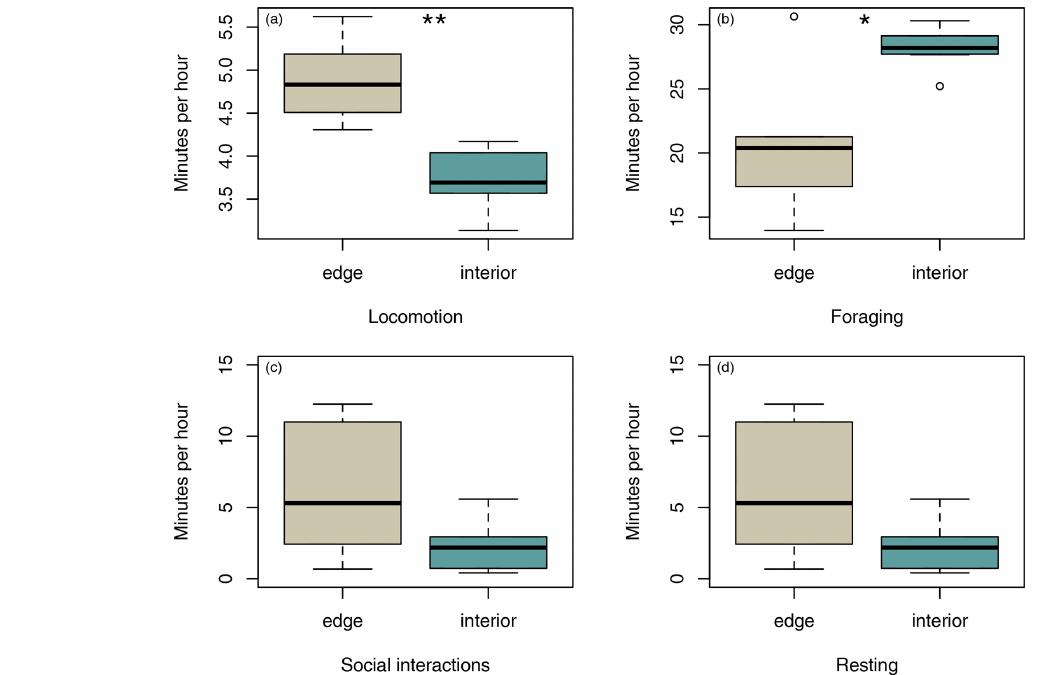
Figure 4. Differences in average duration of (a) locomotion, (b) foraging, (c) social interactions, and (d) resting between groups at the two study sites. Depicted are medians (black horizontal lines), interquartile ranges (boxes), and outliers (circles).